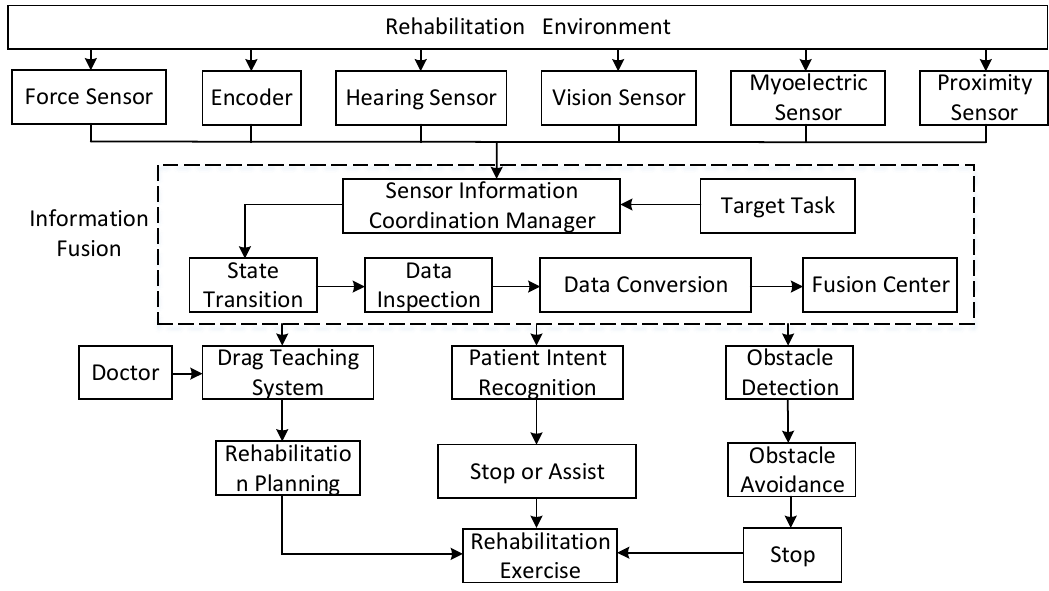
Figure 4. A human-machine natural interaction method based on the multi-sensor system and multi- information fusion method.